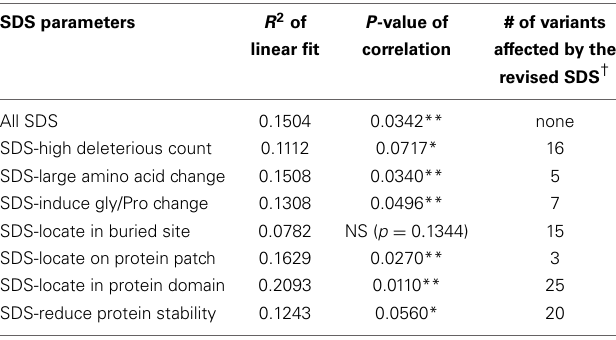
Table 7 | Step-wise analysis for correlation of SDS and Condel